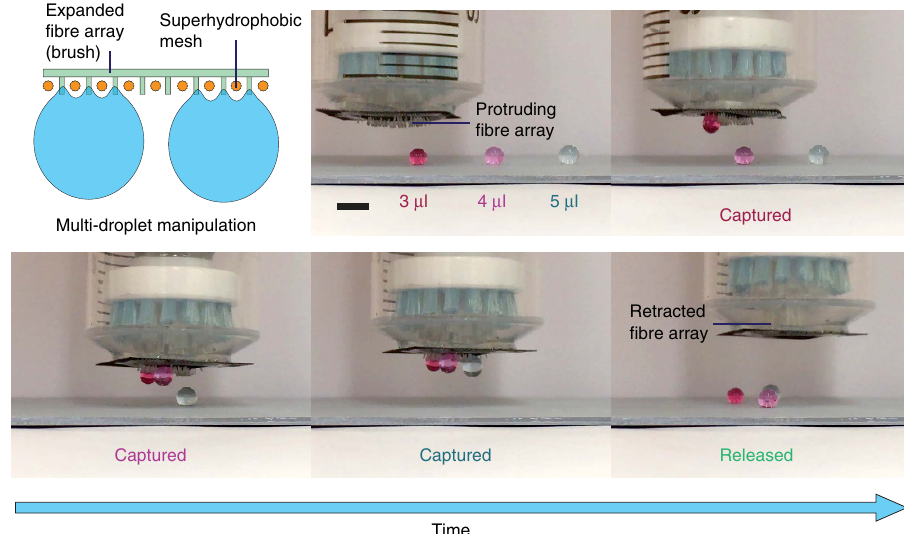
Figure 7 | Manipulation of multiple droplets using a scaled-up MRS. Schematic illustration and time-sequence images showing the in-parallel manipulation of multiple droplets using an MRS with a larger-scale fibre array. The scaled-up MRS successively captures three aqueous droplets (dyed red, magenta and blue) of different volumes and then releases them simultaneously. Scale bar, front of the syringe plunger. Similarly, by pushing and pulling the plunger, the manipulation of oil droplets, a hole was cut in the syringe to prevent the generation flexible bristles could be made to either penetrate or retract through the pores of of negative pressure during the withdrawal of the plunger. For the manipulation the mesh. of multiple droplets, a brush made of Dupont Tynex bristles was adhered to the